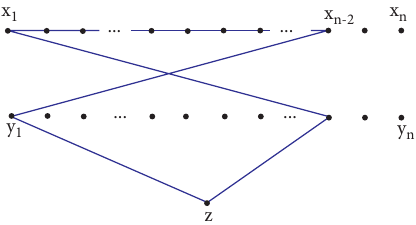
Figure 13: Finding a cycle C